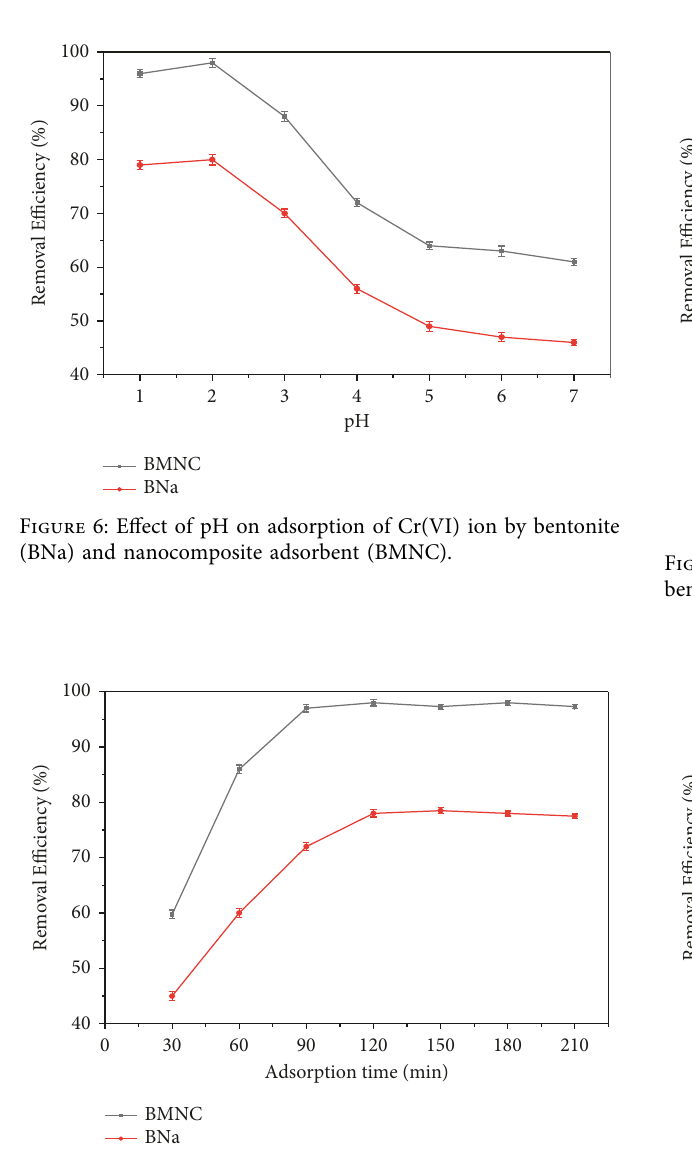
Figure 7: Effect of adsorption time on adsorption of Cr(VI) ion by bentonite (BNa) and nanocomposite adsorbent (BMNC).